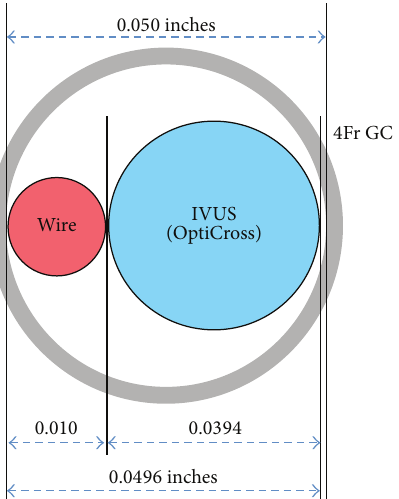
Figure 5: A schematic overview showed the respective diameter of 4Fr guiding catheter, 0.010 guidewire, and intravascular ultrasound